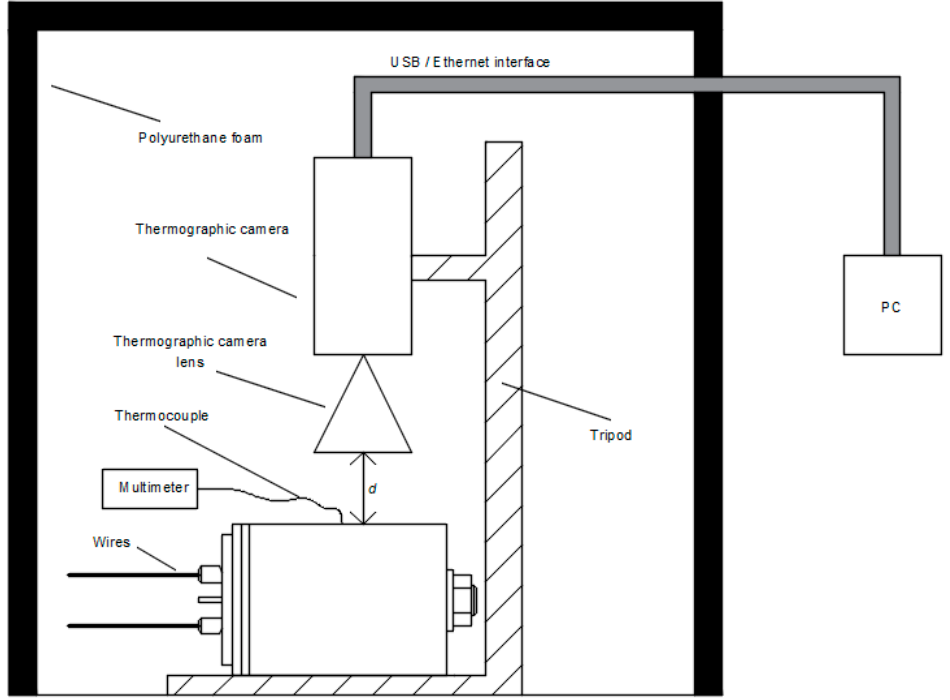
Figure 3. Measuring stand used to verify the temperature distribution obtained in the capacitor case.